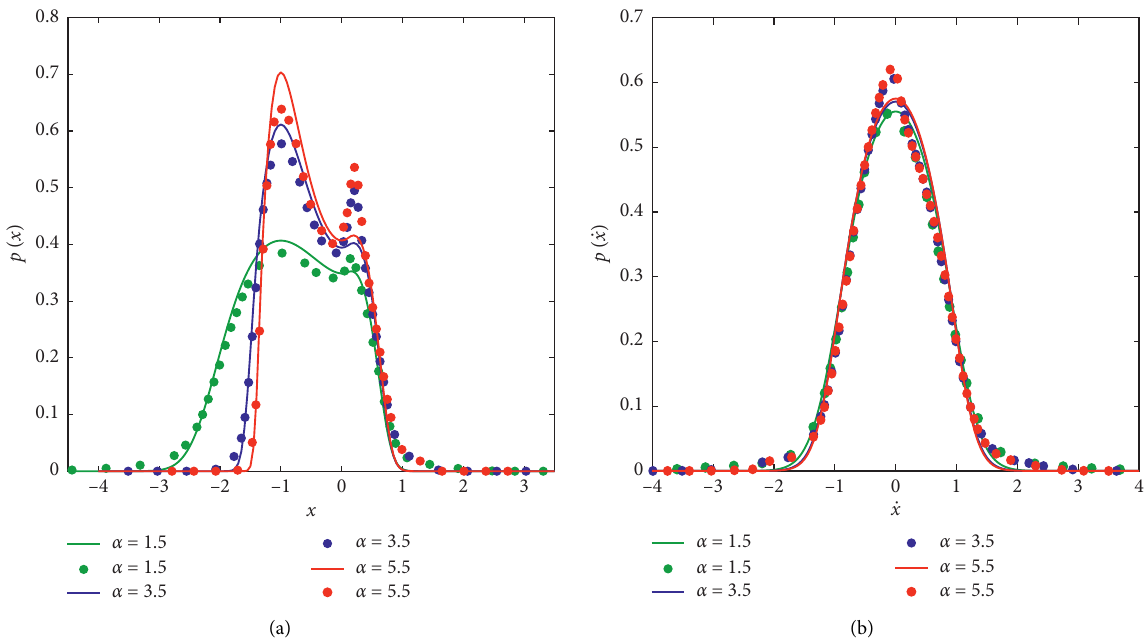
Figure 6: The PDF of the nonlinear system under a different fractional order α . (a) The displacement PDF; (b) the velocity PDF ( k solid lines: the analytical results, and circles: MCS